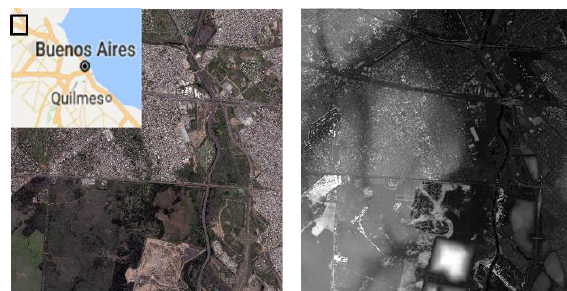
Figure 2. The orthophoto (RGB band) and the DSM generated from satellite imagery with 0.3 m spatial